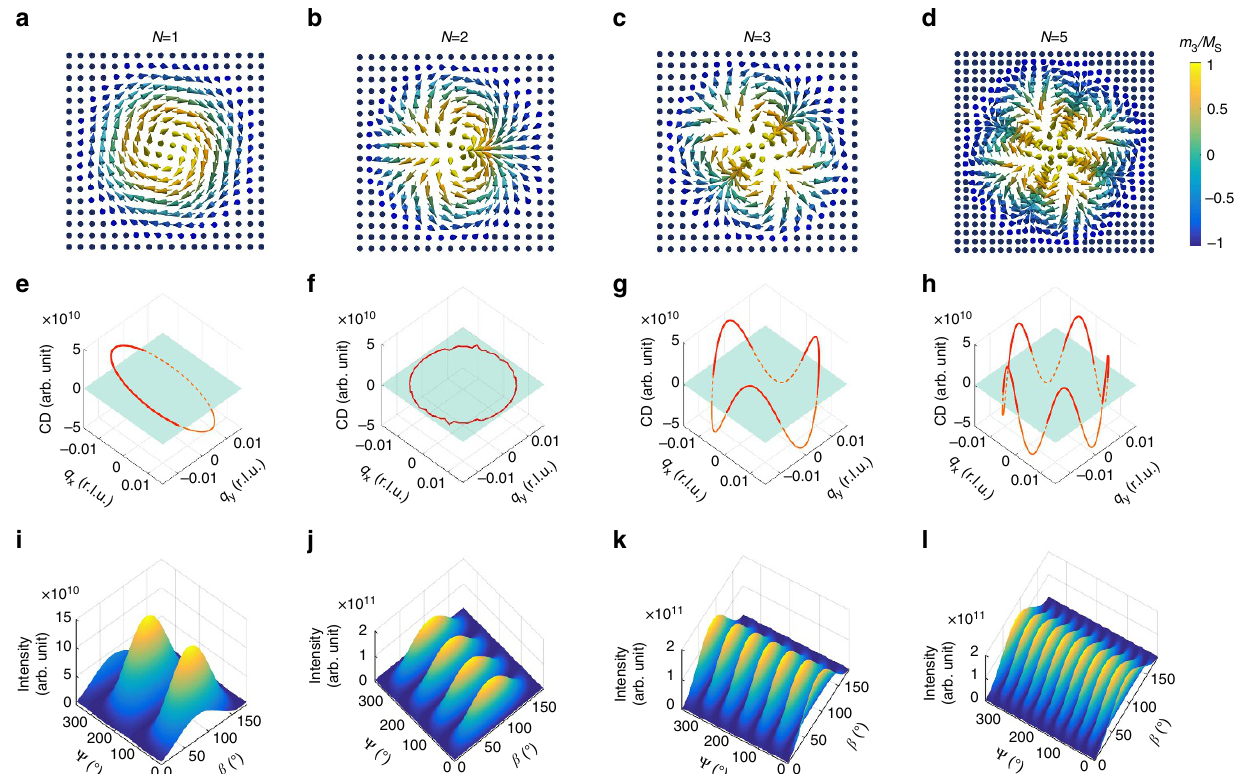
Figure 2 | Numerical determination of the topological winding number. ( a – d ) Spin configurations with topological winding numbers of 1, 2, 3 and 5, respectively. These spin textures are the motifs that generate the two-dimensional, periodically ordered lattices which can be measured by diffraction techniques. ( e – h ) CD cross-section as a function of C for topologically ordered systems. Here, C is represented by a loop (shown in red) in reciprocal space ( q diff , q diff ), where q diff q cos C , q diff q sin C , and q ¼ 0.0158 r.l.u. is the absolute value of the skyrmion lattice modulation wavevector for x y x ¼ y ¼ Cu 2 OSeO 3 . The condition for vanishing CD (CD ¼ 0) is indicated by the light blue plane. The CD signal is symmetric about this plane for integer winding numbers. The periodicity of the CD modulation equals to N . Note that for even N the CD signal is zero. ( i – l ) PAMs. The calculations are performed by rotating b from 0 (cid:2) to 180 (cid:2) at each C , and by mapping out C from 0 (cid:2) to 360 (cid:2) . The total number of humps is equivalent to 2 N . Note that for integer winding numbers the humps are of equal